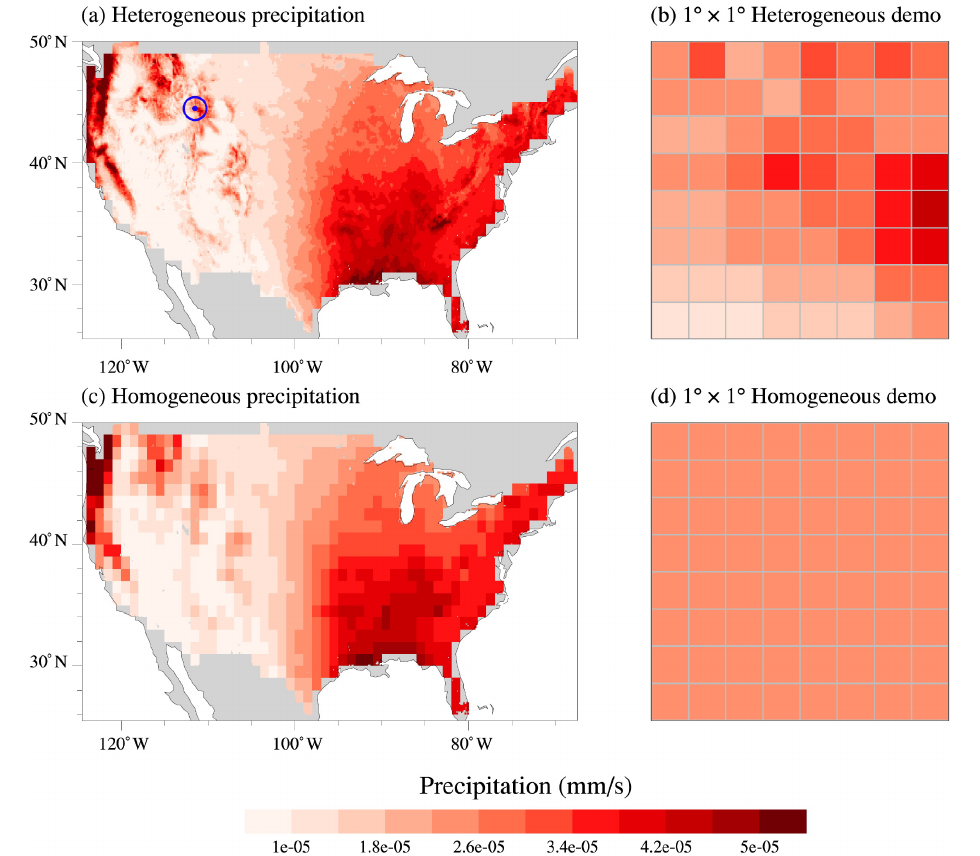
Figure 1. Annual climatology of (a) heterogeneous and (c) homogeneous precipitation over CONUS. The corresponding (b) heterogeneous and (d) homogeneous precipitation over a 1 ◦ × 1 ◦ region (latitude: 37–38 ◦ N, longitude: 111–110 ◦ W, the blue marker in a ) is also